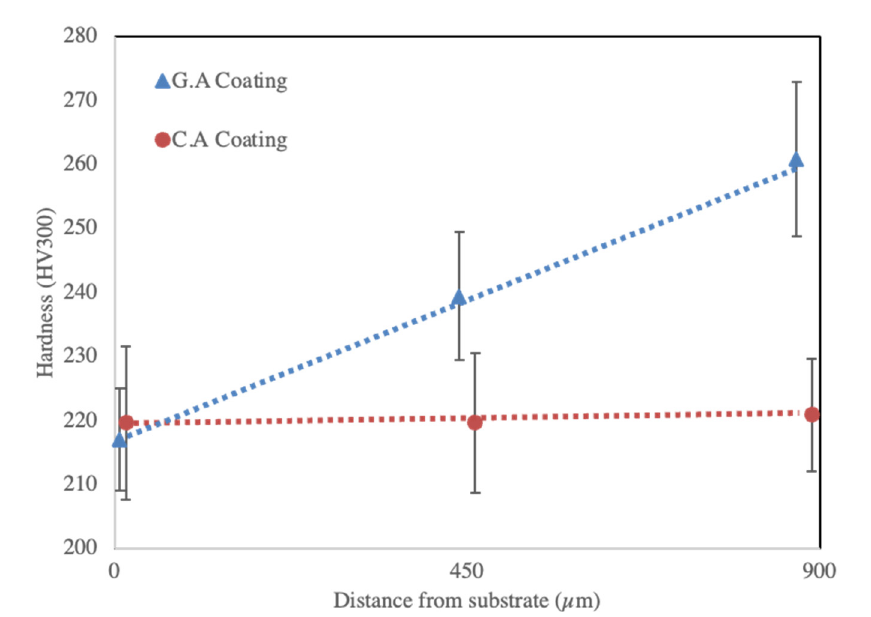
Figure 13. Micro ‐ hardness values of coatings. Figure 13. Micro-hardness values of coatings.